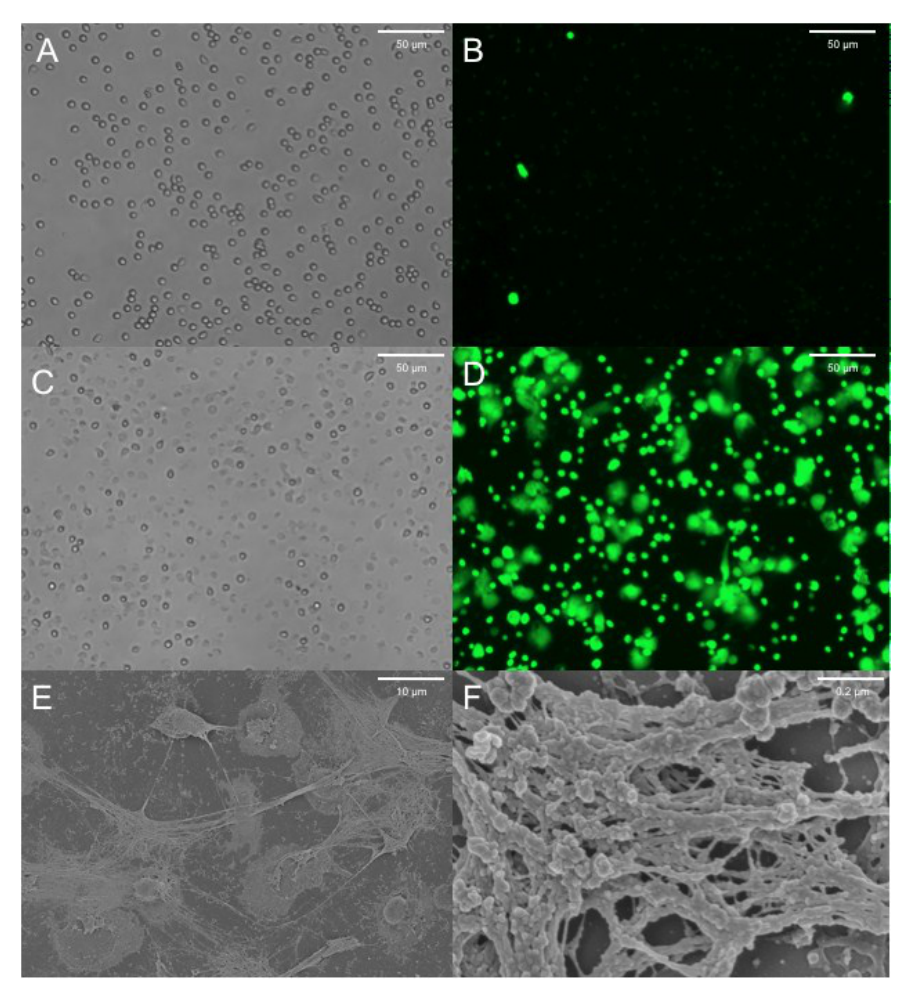
Figure 2. Porcine CFTR −/− neutrophils stimulated with LPS to produce NETs. Cells were plated at a density of 50,000 cells per well in 24 well plates and treated for 6–8 h with LPS 100 μg/mL or control. Cells were then stained with Sytox green, which preferentially stains extracellular DNA and is excluded from live cells. ( A ) Brightfield image of untreated neutrophils showing normal morphology; ( B ) Sytox staining of untreated neutrophils demonstrates minimal staining for extracellular DNA; ( C ) Brightfield image of LPS treated neutrophils showing flattened and activated cells; ( D ) Sytox staining of LPS treated neutrophils showing characteristic NET structures; ( E , F ) Scanning electron microscopy (SEM) of fixed preparations at low and high magnification demonstrating characteristic mesh-like structures of NETs following LPS